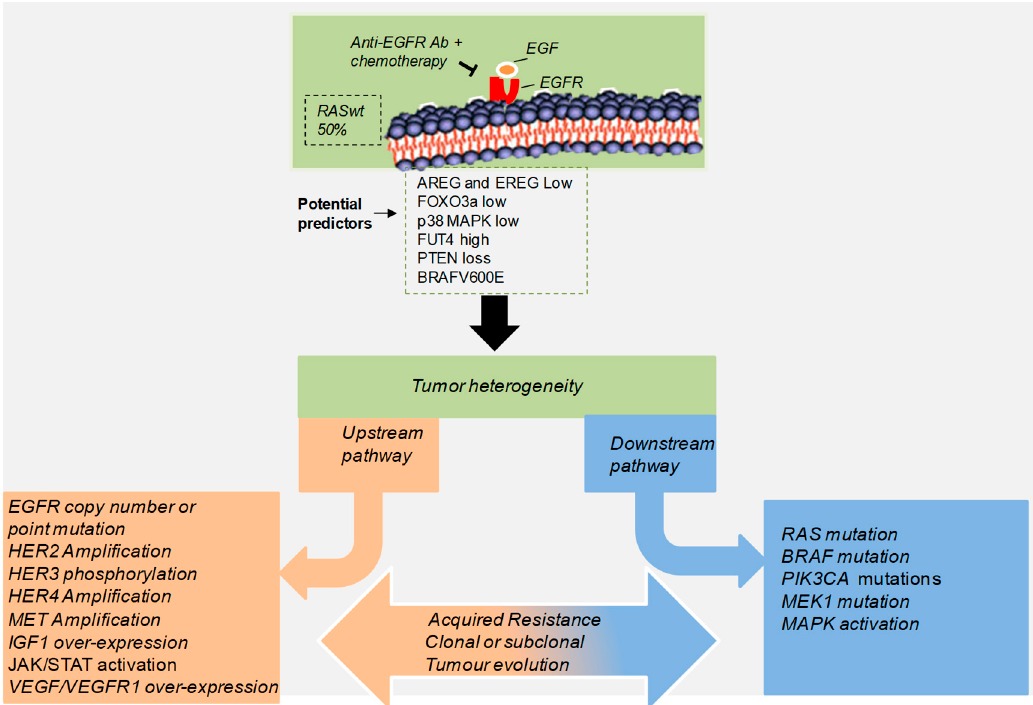
Figure 1. Aberrant genetic alterations implicated in the resistance to anti-EGFR therapy. Anti-EGFR targeted therapy is combined with other cancer treatments in patients with advanced colorectal cancer bearing wild type RAS. While patients respond fairly well initially, in most cases sustained treatment typically results in the failure of the response to treatment and a poor prognosis. This therapy acting as a selection pressure, enables tumor cells to acquire extensive genetic alterations, leading to abnormal activation or amplification of di ff erent tyrosine kinase receptors (upstream) and downstream signaling pathways dependent or independent of EGFR signaling. These mechanisms can be expanded through parallel evolution, enabling tumor cells to adapt, while maintaining their intratumoral heterogeneity that contributes to